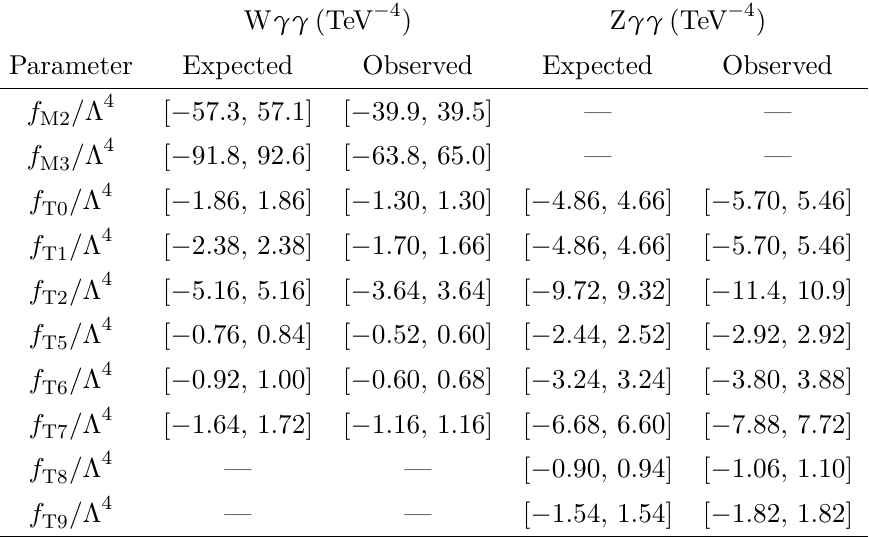
Table 3 . Expected and observed 95% confidence level intervals for the different anomalous couplings in both the W gg and Z gg